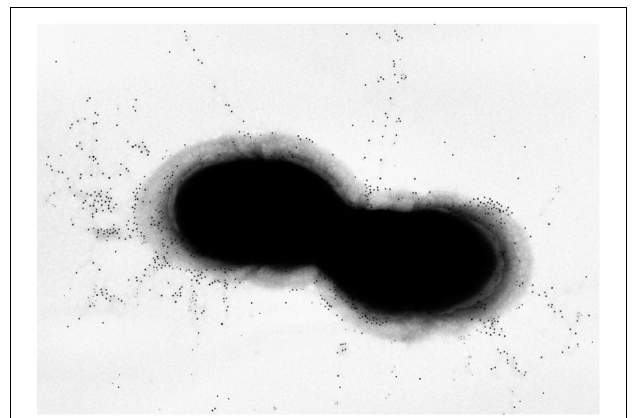
FIGURE 1 | Pilus Island-2a. Immunogold transmission electron microscopy of GBS 515 grown to exponential phase. Bacteria were incubated with polyclonal sera raised against the corresponding pilus 2a backbone variant obtained as recombinant protein, and labeled with secondary antibodies conjugated with 10nm gold